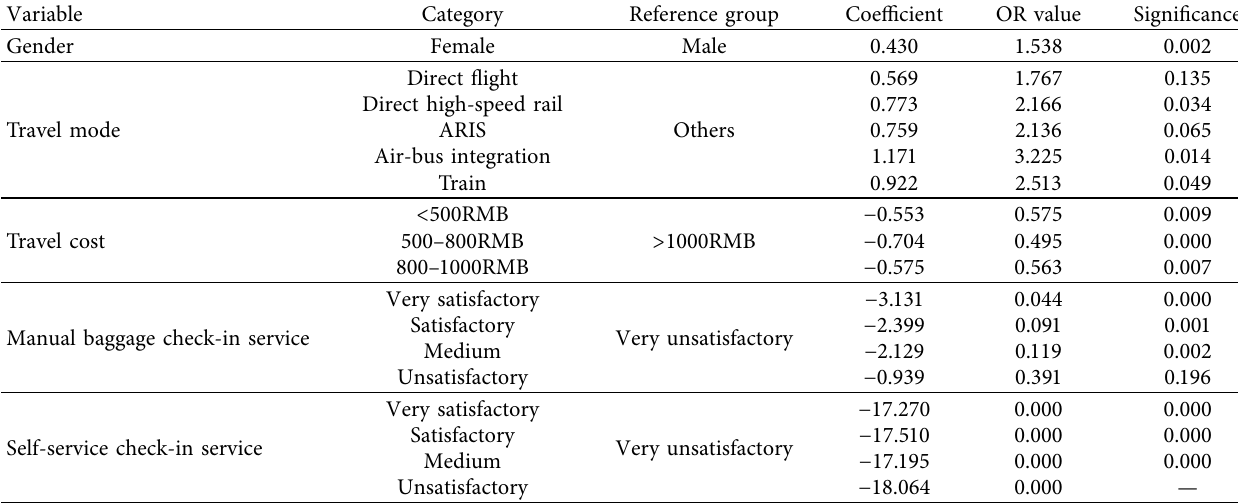
Table 6: Regression analysis of the infuencing factors of check-in and baggage check reservation time.